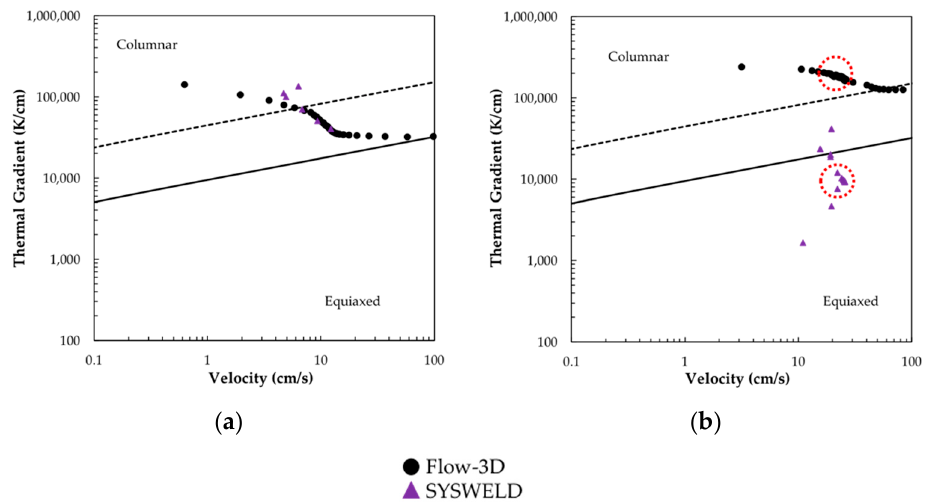
Figure 12. Predicted FLOW-3D and SYSWELD G-V conditions at the top of the melt pool overlaid onto the Ti-1023 CET for ( a ) 139 W spot-melt and ( b ) 53.5 W and 0.25 m/s raster. Note: circles in ( b ) show the steady-state regions.